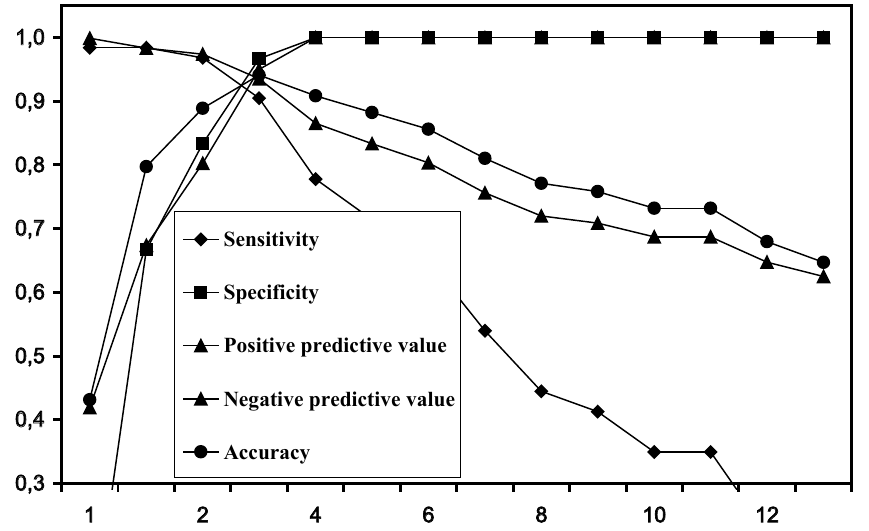
Fig. 4. Ratio of enddiastolic velocities in the internal and common carotid